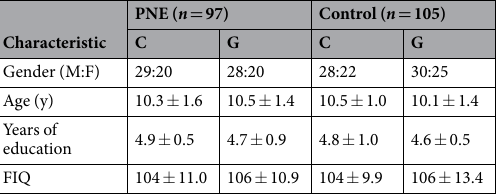
Table 1. Demographic and behavioral data a . Abbreviations: PNE, primary nocturnal enuresis; FIQ, Full-scale Intelligence Quotient. a Data are presented as the mean ± standard deviation. b No significant differences are found in any measures between GG and GC/CC individuals.